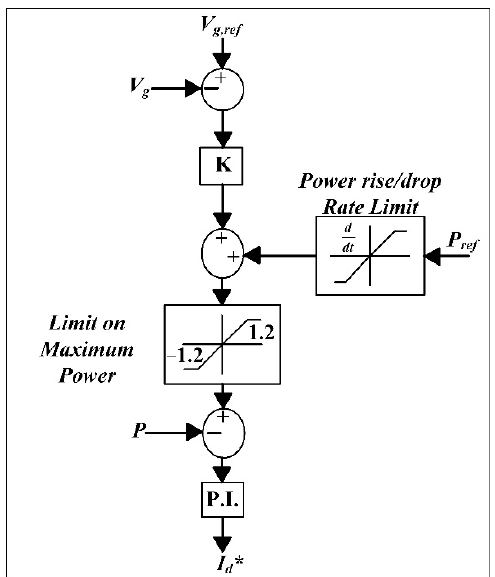
Figure 5. Improved proportional droop control.